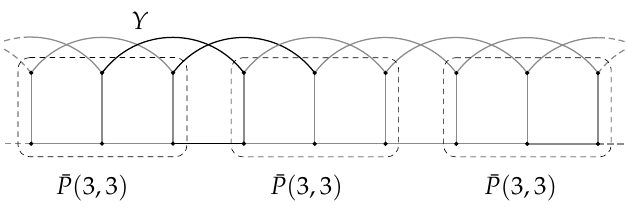
Figure 4. P ( 3 n ,3 ) as a